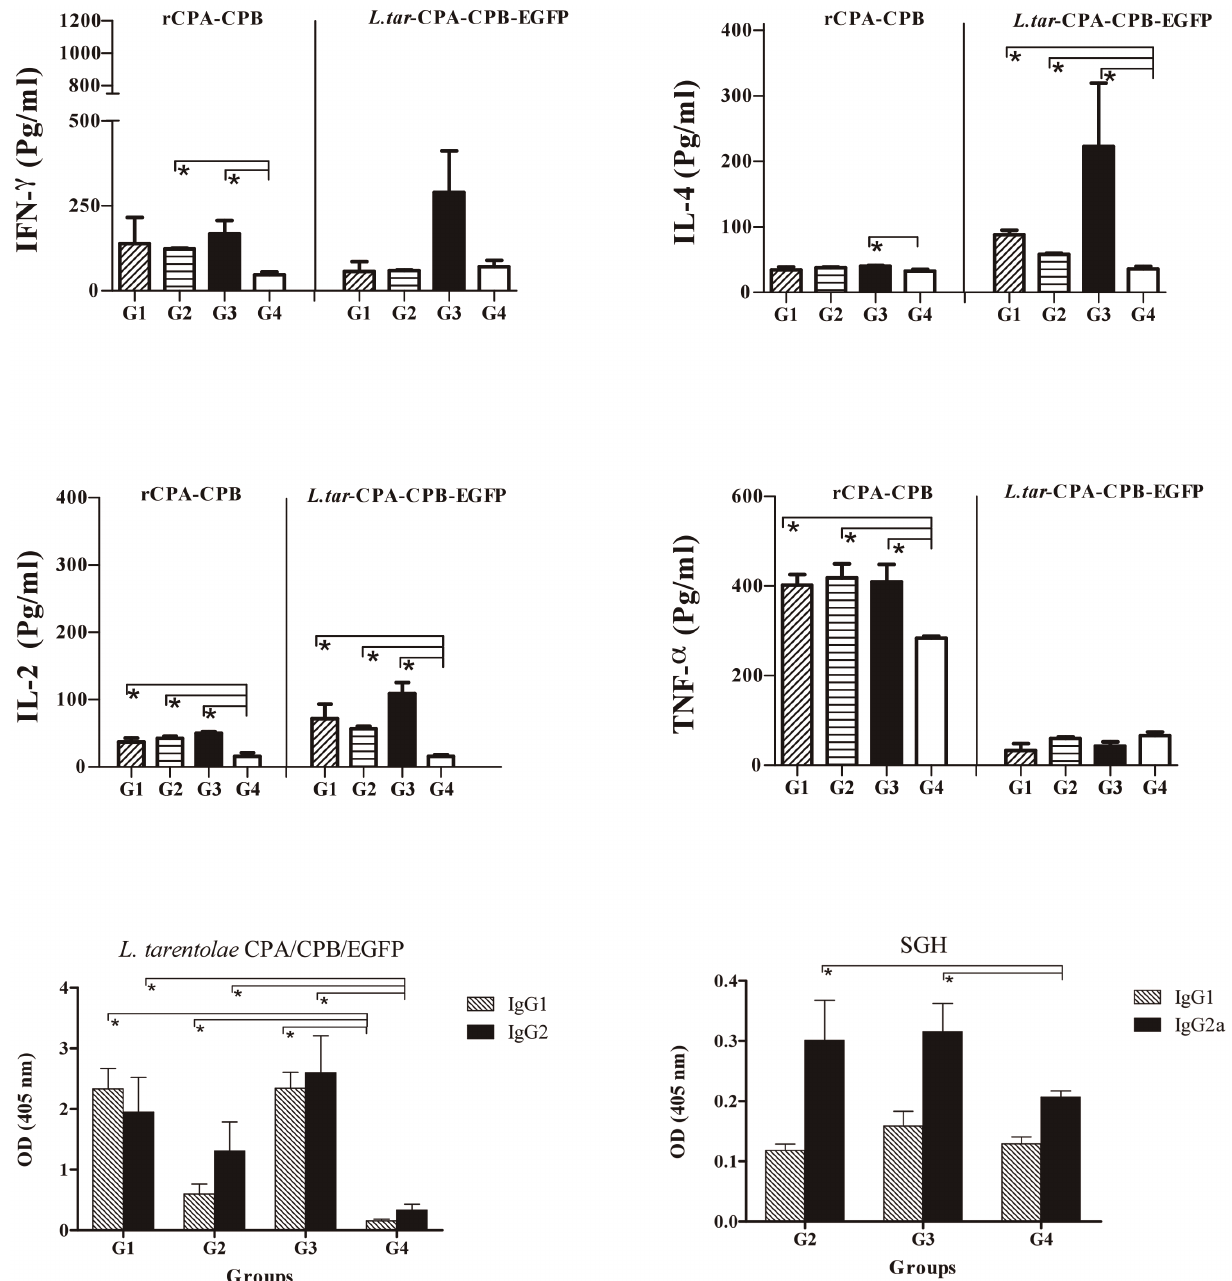
Figure 2. Cellular and humoral immune responses by splenocytes of BALB/c mice after booster immunization. A) Cytokine production from the splenocytes of 4 mice in the designated groups 3 weeks after last immunization. Single cell suspensions were cultured in duplicate in the presence of recombinant CPA/CPB or freeze-thawed recombinant L. tarentolae . Culture supernatants were assayed for IFN- c , IL-4, IL-2 and TNF- a production by ELISA. Each bar represents the Mean 6 SD of 4 mice per group. B) Antigen specific antibody responses against L. tarentolae CPA/CPB/ EGFP and SGH before parasite challenge. Data were generated as Mean 6 SD for sera of individual mice within their respective vaccination group (n=8–10). The asterisk indicates the significant difference between values at the indicated time points as determined by Mann Whitney U test ( p , 0.05 denoted as *), compared to the control group (G4). Results are representative of two independent experiments.